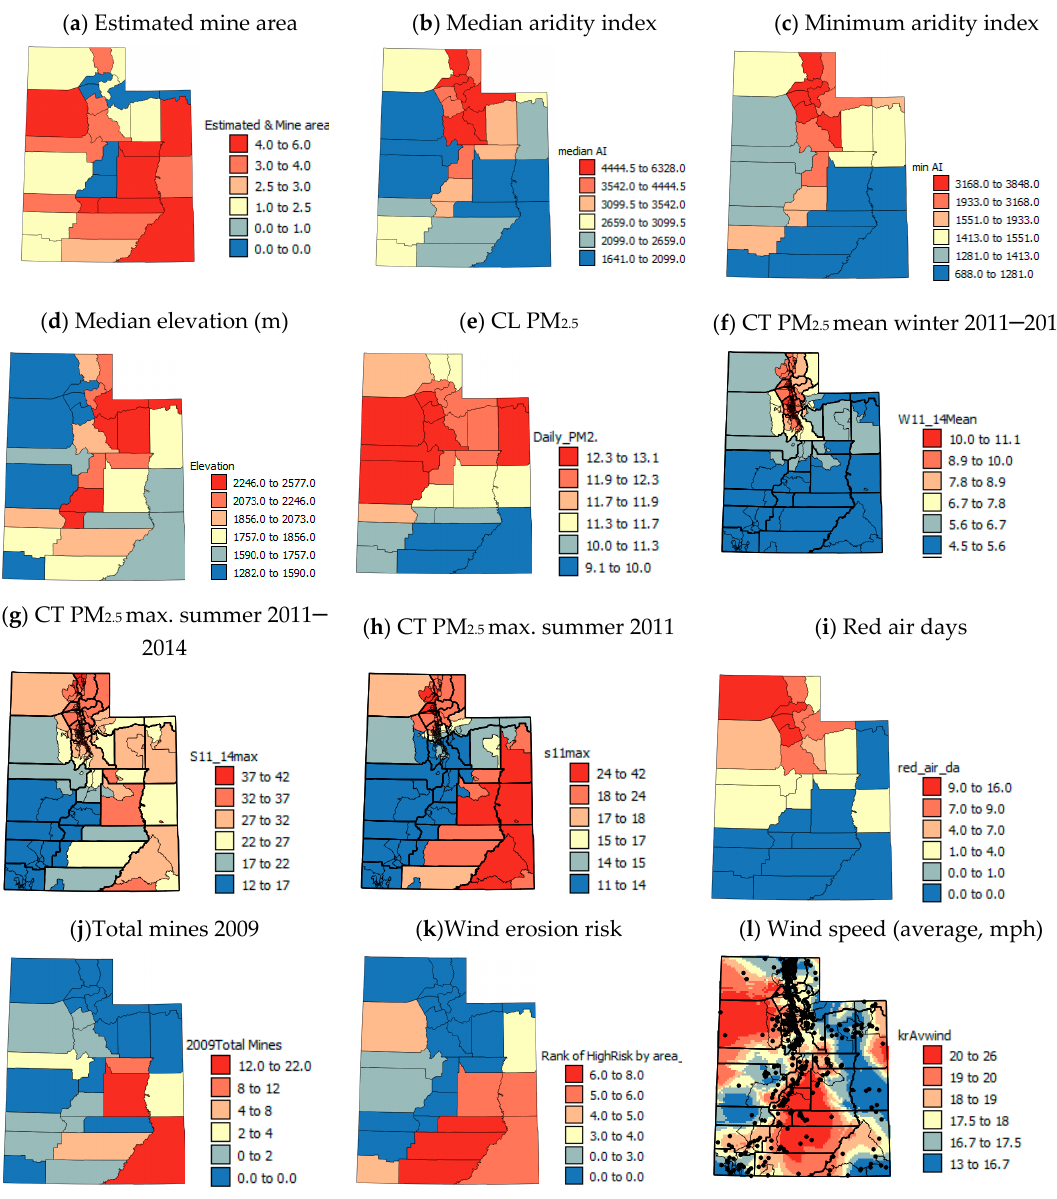
Figure 3. Maps of environmental variables.